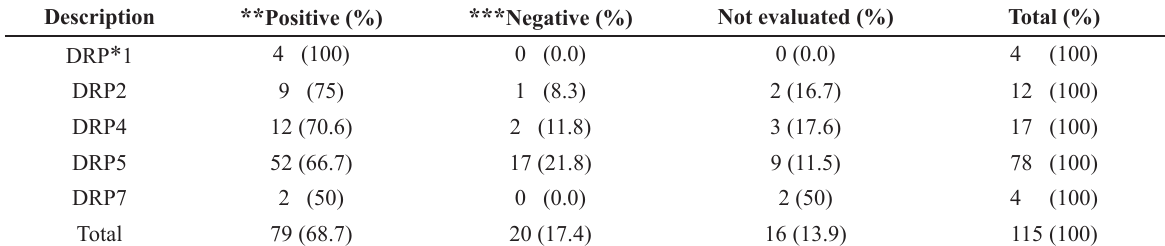
Description of results by Drug-Related Problems category for tuberculosis patients that received intervention, August 2009 to July 2012, Belo Horizonte (n = 62). Description